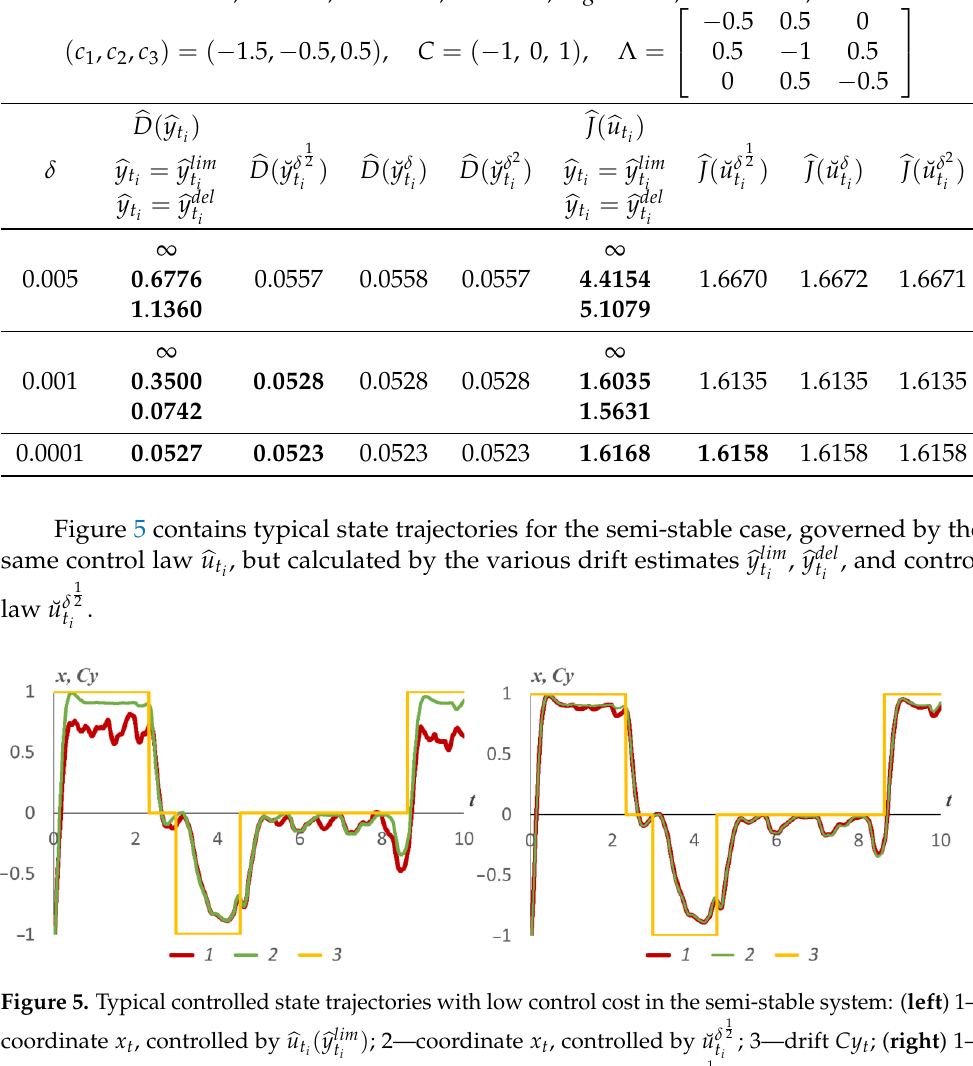
1 2 ; 3—drift Cy t ; ( right ) 1— t i 1 2 ; 3—drift Cy t . t i